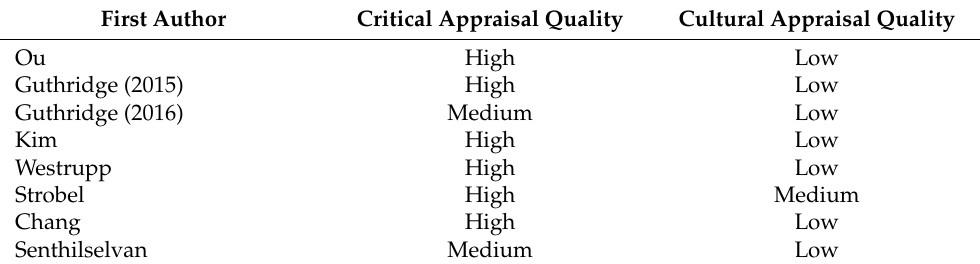
Table 3. Critical and cultural appraisal of the included studies ( n =